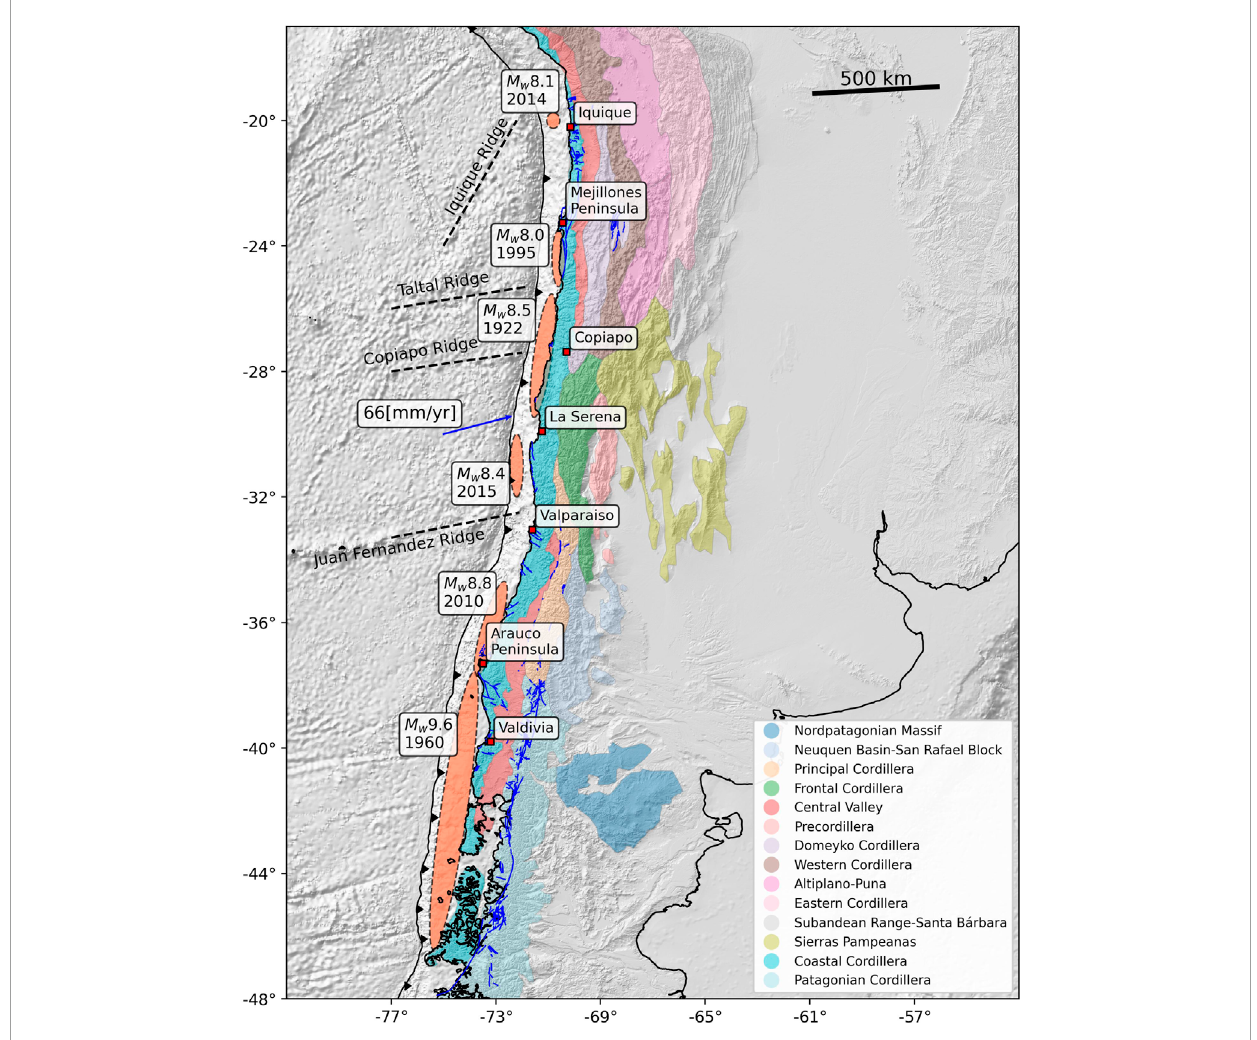
FIGURE 1 Location of the study zone. Orange ellipses represent the approximate rupture area of the earthquakes from the last 100 years in the region (Delouis et al., 1997; Beck, 1998; Ruiz et al., 2016). Red squares represent cities and relevant coastal features. Blue arrow represent the convergence velocity between Nazca and Sudamerica. Blue lines represents faults traces from (Maldonado et al., 2021). Colored regions represents the